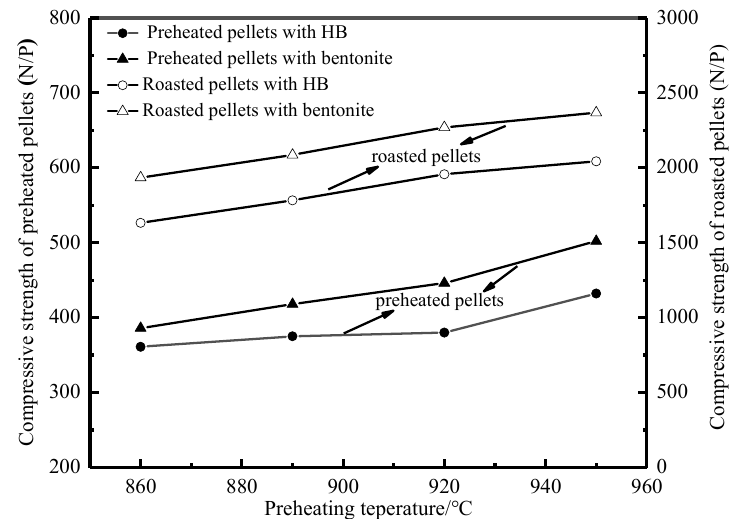
Figure 6. Effects of preheating temperature on the compressive strengths of pellets with binders, preheating time 14 min for humic substance-based binder (HB), preheating time 10 min for bentonite.